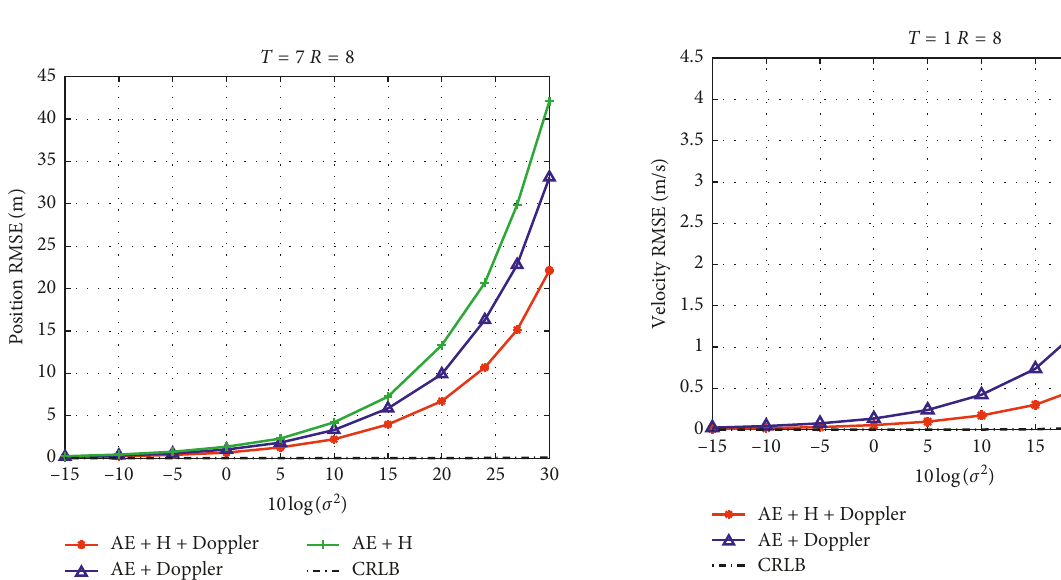
shifts (AE + H + Doppler), and curves marked with triangle